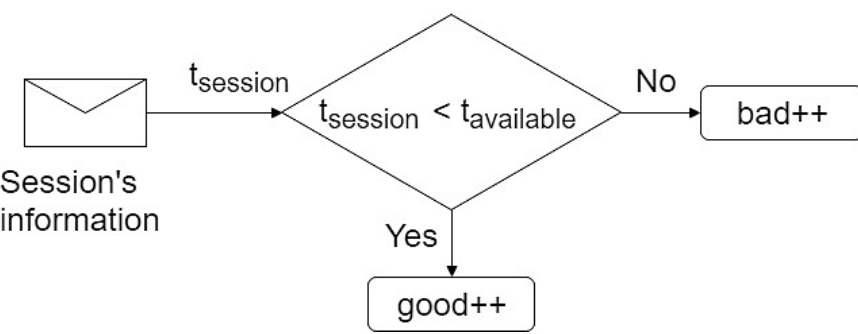
Figure 6. Distribution of the services quality and assessments in the network.